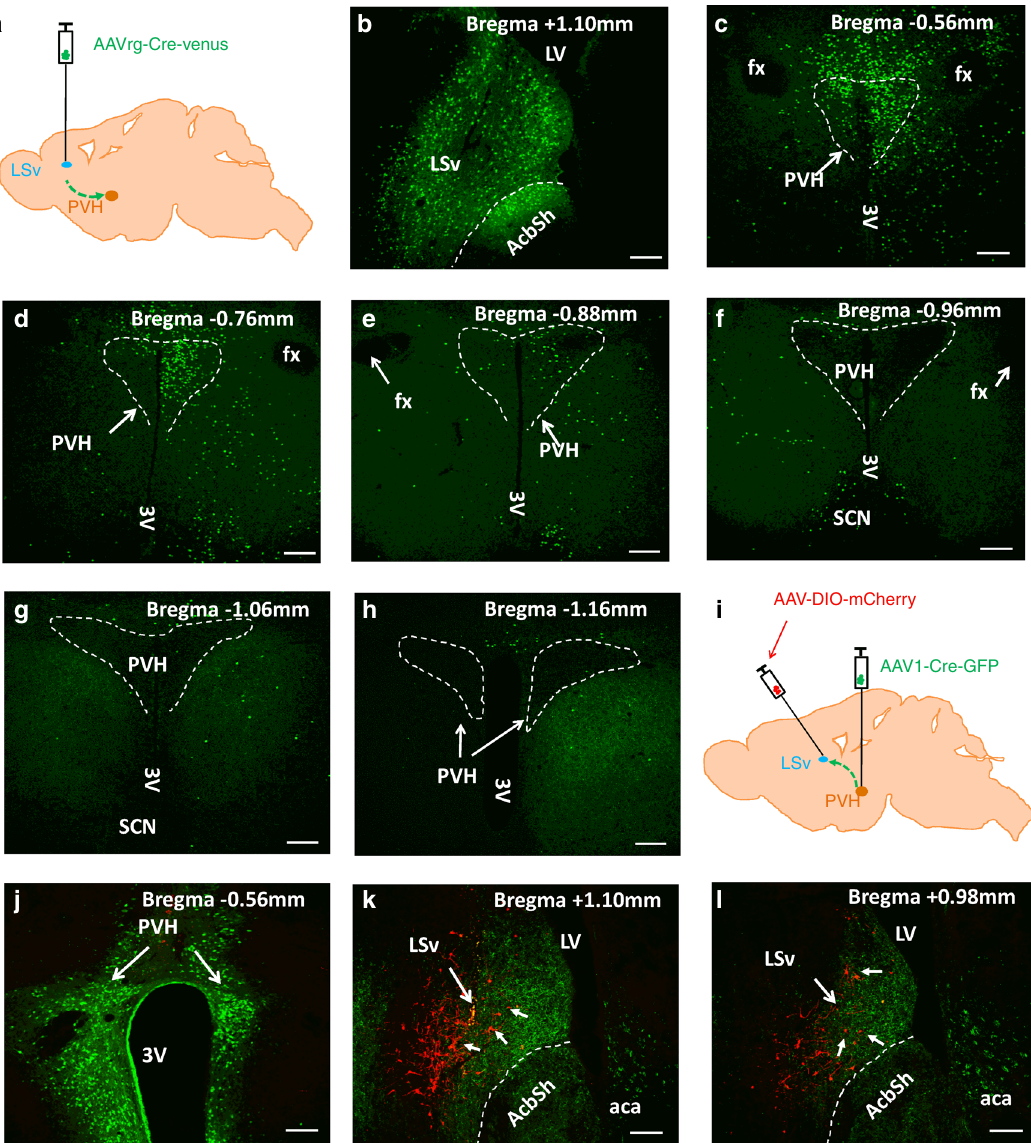
Fig. 8 Tracing between PVH and LSv. a – h Retrograde tracing from the LSv to PVH. a Diagram showing delivery of retrograde AAVrg-Cre-Venus to the LSv of adult wild-type male mice and examination of traced upstream neurons including the PVH. Con fi rmation of vector expression in the LSv b , and the traced neurons in brain sections with various Bregma levels from rostral to caudal PVH c – h . i – l Anterograde tracing from the PVH to LSv. i Diagram showing delivery of anterograde AAV1-Cre-GFP to the PVH of adult wild-type mice and of Cre-dependent AAV-DIO-mCherry vectors to the LSv for examination of traced downstream LSv neurons. Con fi rmation of AAV1-Cre-GFP expression in the PVH j and mCherry-expressing neurons in the LSv k and I . Scale bar = 100 µ M . The white line enclosed areas in c – h outlining the PVH. Short arrows in k and l pointing to mCherry-expressing neurons. SCN: suprachiasmatic nucleus; LV: lateral ventricle; LSv: ventral part of lateral septum; fx: fornix; 3 V: the third ventricle; aca: anterior commissure area; AcbSh: accumbens